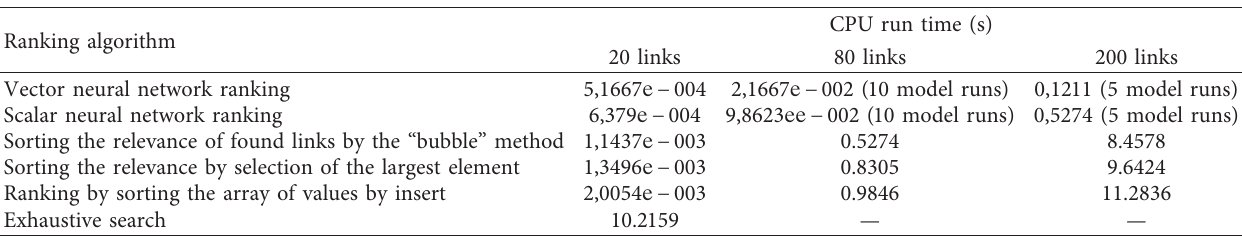
Table 3: Results of experimental comparison of the efficiency of problem solving with the number of ranked links from 20 to 200. Ranking algorithm Vector neural network ranking